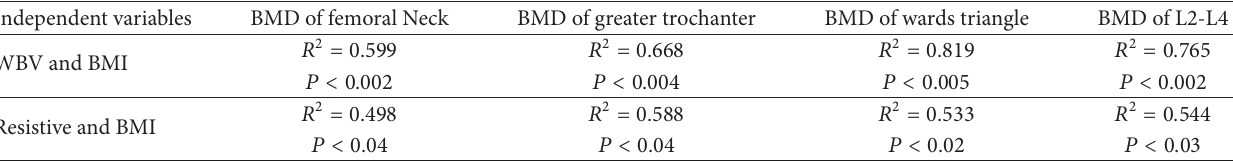
Table 5: Multiple regression results for anthropometry and physical activity in obese postmenopausal women. Independent variables BMD of femoral Neck BMD of greater trochanter BMD of wards triangle BMD of L2-L4 WBV and BMI Resistive and